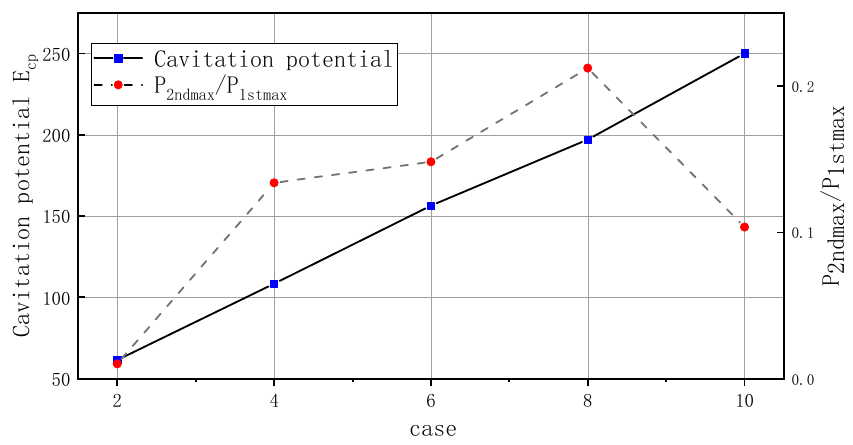
Figure 14. Ratio of two pressure peaks recorded by the probe p 2ndmax /p 1stmax and cavitation potential E cp for different cases.